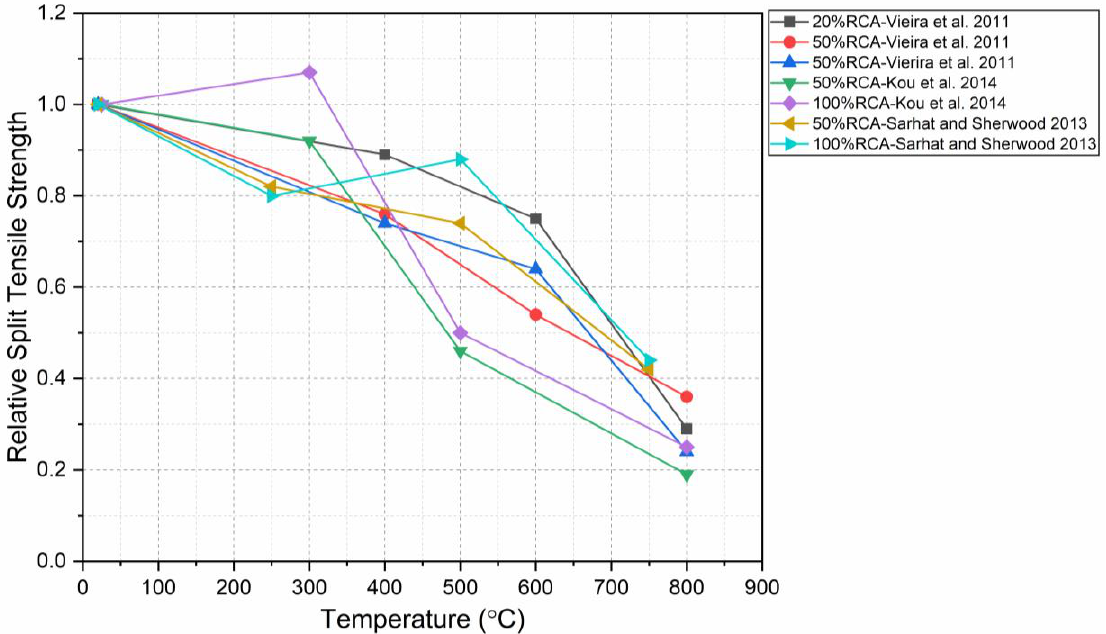
Figure 6. Relative splitting tensile strength of RAC with varying elevated temperature and propor- tions of RCA [66,75,79].